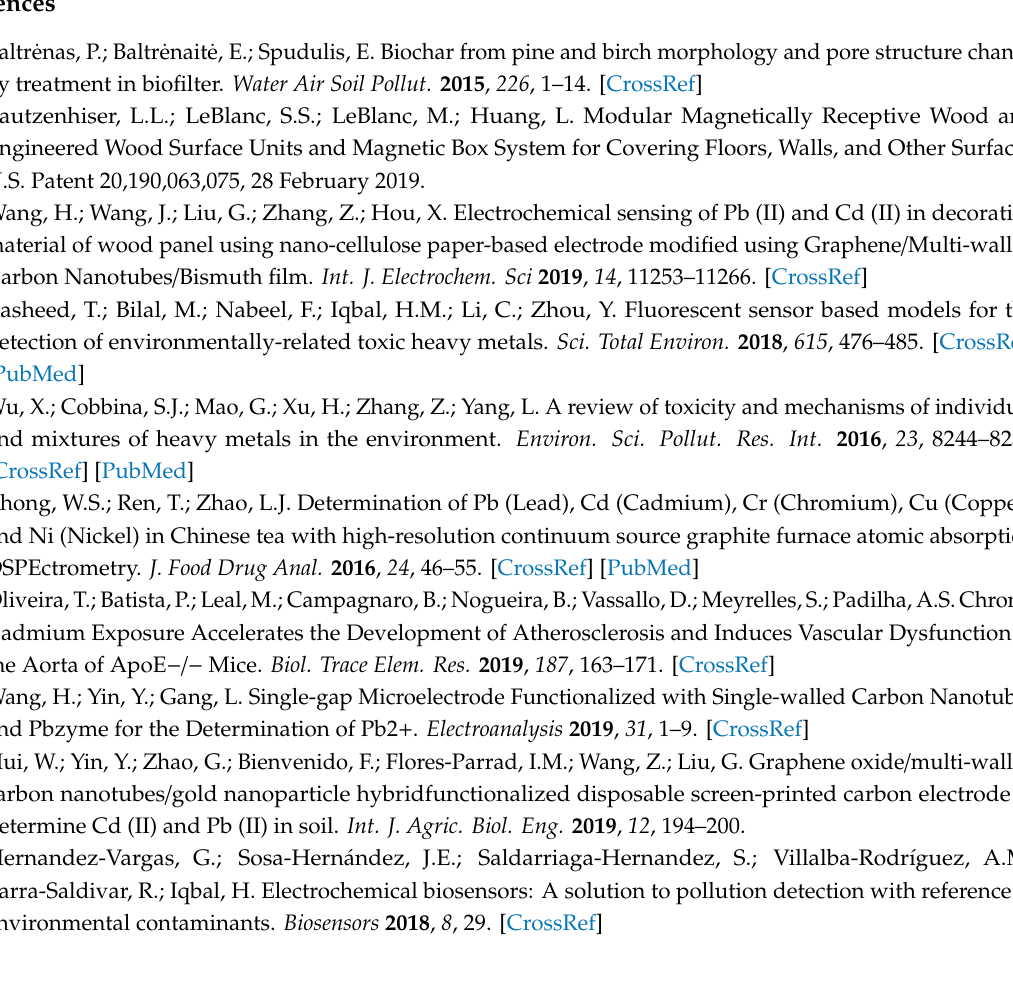
Figure S1: The stripping responses of Cd(II) and Pb(II) a ff ected by the di ff erent pH of the acetic acid bu ff er solution, Figure S2: The stripping responses of Cd(II) and Pb(II) a ff ected by the di ff erent Bi(III) concentrations, Figure S3: The stripping responses of Cd(II) and Pb(II) a ff ected by the deposition times, Figure S4: The stripping responses of Cd(II) and Pb(II) a ff ected by the deposition potentials, Figure S5: The stability of the Bi / LC-rGO / DSPE measured with 20 µ g / L of Cd(II) and Pb(II) every two